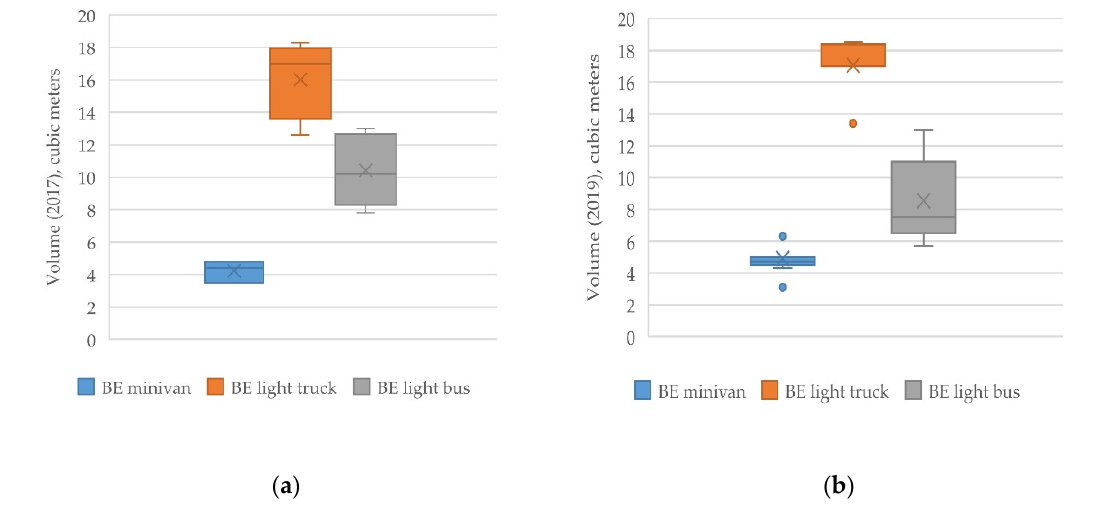
Figure 7. Volume distribution of the various BELVs, ( a ) 2017 and ( b ) 2019.